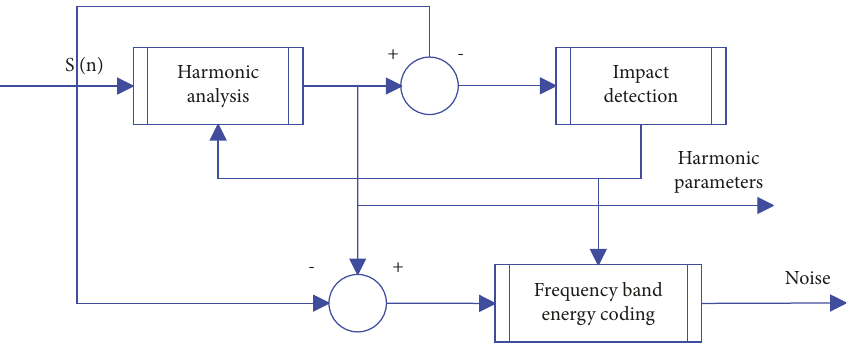
Figure 7: STN algorithm encoding only harmonic parameters and noise.